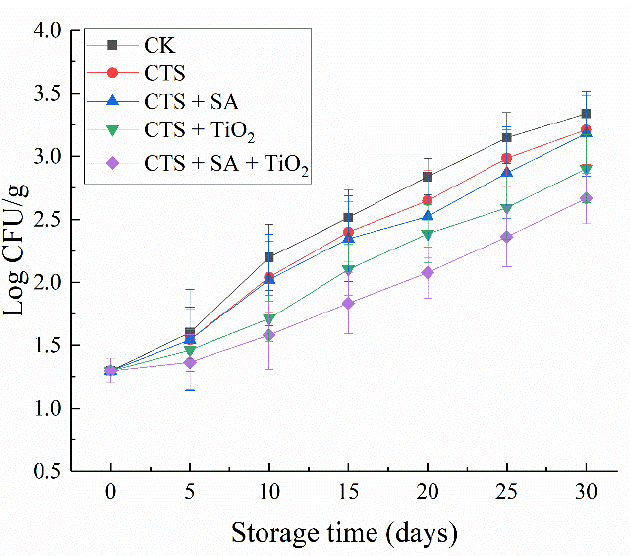
Figure 6. The colony units of each handle group in blackcurrants during 30-day storage at 4 °C.